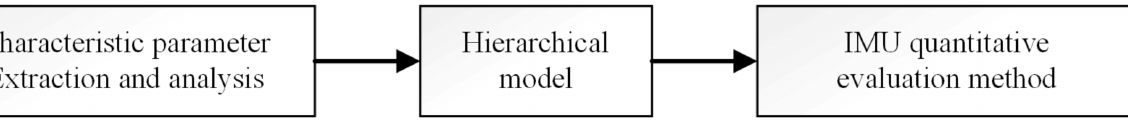
Figure 5. Flow chart of quantitative assessment model